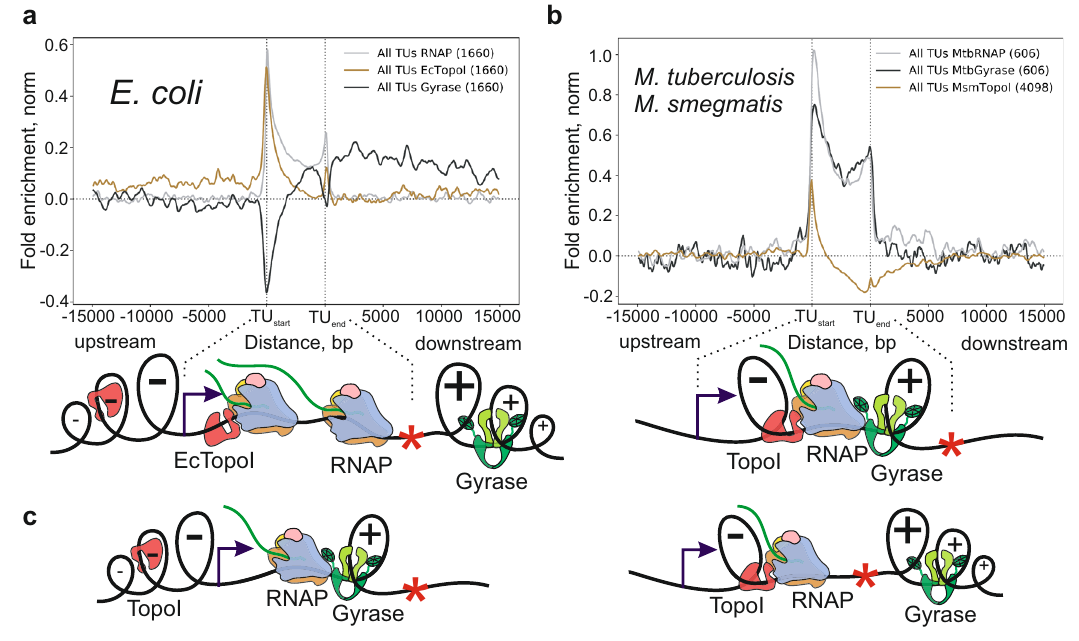
Fig. 6 | Possible variations of the twin-domain model. Average normalized enrichment of TopoI, DNA gyrase, and RNAP over transcription units of E. coli ( a , “ open ” model) and Mycobacterium ( b , “ closed ” model). Graphical representa- tions of twin-domain sub-models are shown below. ChIP-Seq data for M. tubercu- losis MtbRNAP, MtbGyrase, and M. smegmatis MsmTopoI was taken from publicly